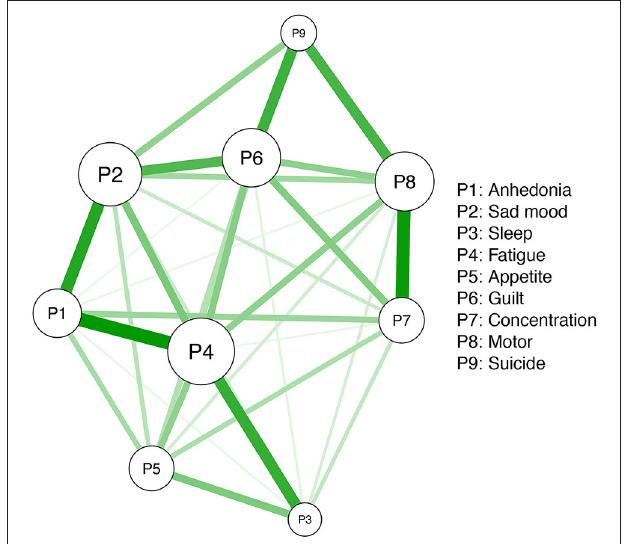
FIGURE 1 | The estimated network structure of dichotomized PHQ-9 symptoms.